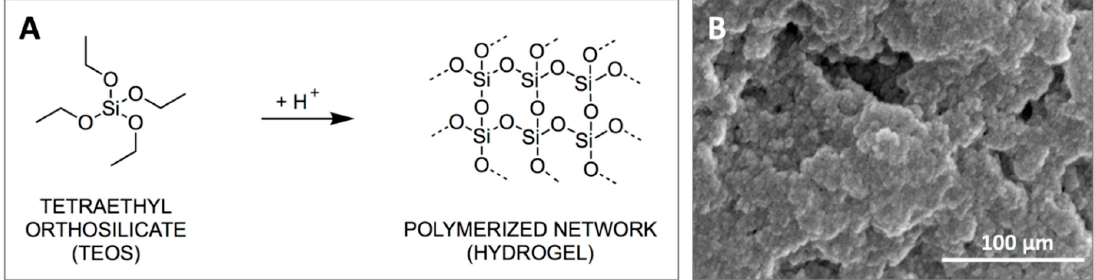
Figure 1. Tetraethyl orthosilicate (TEOS)-based hydrogel formation. ( A )—reaction mechanism; ( B )—nanoparticular structure of the hydrogel.